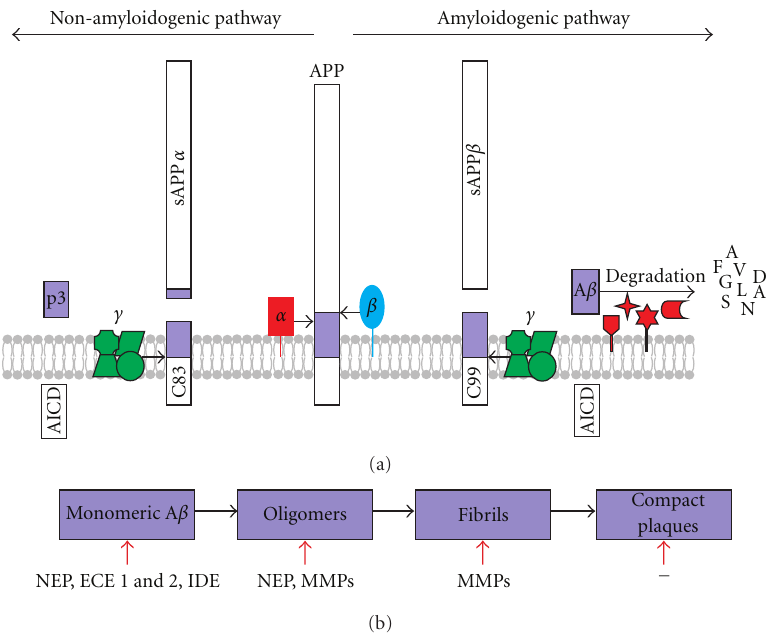
Figure 2: Zinc metalloprotease activity in APP processing. (a) In the amyloidogenic pathway, the transmembrane APP is cleaved first by β -secretase ( β ) to form the soluble sAPP β and the membrane-bound C99, which in turn is cleaved by γ -secretase ( γ ) to form AICD and the amyloidogenic A β peptides. The A β peptides are degraded by a number of zinc metalloproteases including NEP and IDE. In the nonamyloidogenic pathway, APP is cleaved first by the α -secretase ( α ) (zinc metalloprotease) to form the soluble sAPP α and the membrane bound C83, which is then cleaved by γ -secretase ( γ ) to form p3 and AICD. Zinc metalloproteases depicted in red. Representative amino acids from the degradation of A β are shown in single letter code. (b) Action of zinc metalloproteases on monomeric and aggregated forms of A β (modified from [43]). A β : Amyloid β ; AICD: APP intracellular domain; APP: Amyloid precursor protein; ECE: Endothelin-converting enzyme; IDE: Insulin degrading enzyme; MMP: Matrix metalloprotease; NEP: Neprilysin.